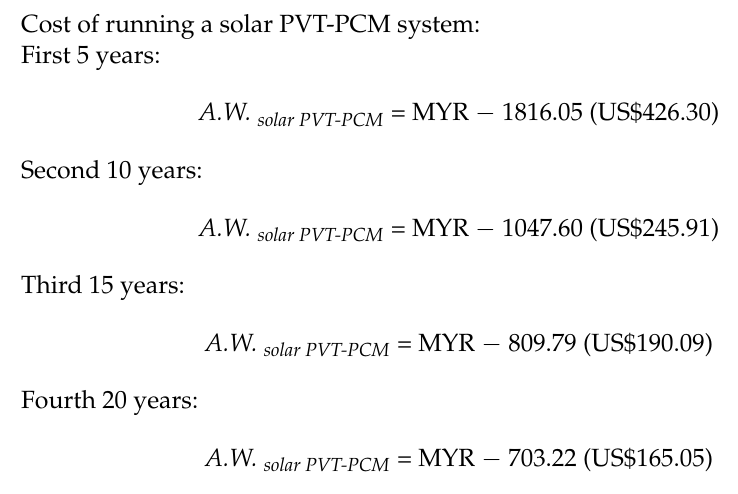
Figure 9. Solar PVT-PCM system cash flow diagram.